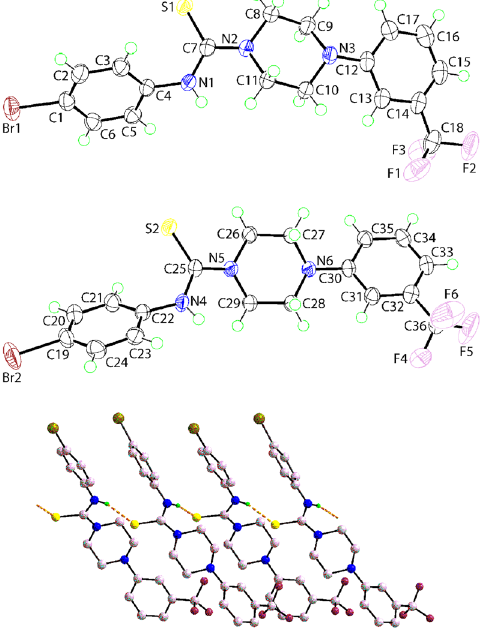
Table 1 contains crystallographic data and Table 2 contains the list of the atoms including atomic coordinates and displacement parameters.